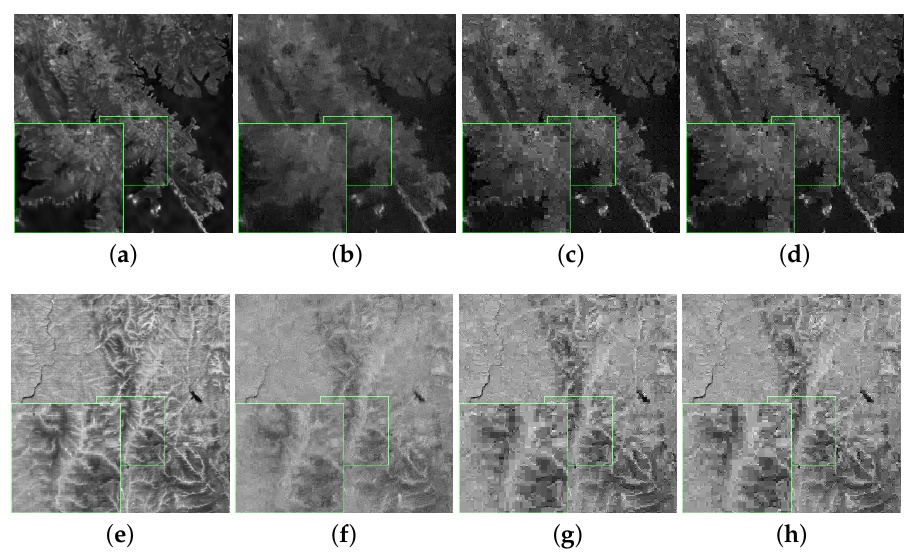
Figure 8. The reconstruction results for a sample rate of 0.1 and a noise level of σ = 8.